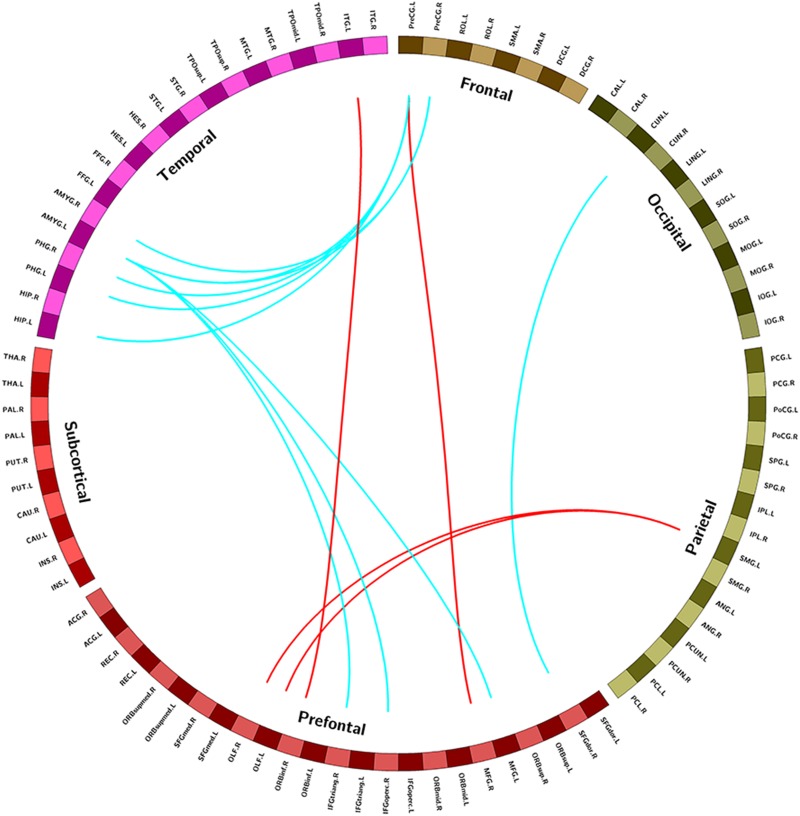
Regions exhibiting intergroup different FC between pregnant women with NSCLP and controls (p < 0.005, uncorrected). Brain regions were defined according to the AAL altas (Tzourio-Mazoyer et al., 2002), red edges were increased FC in NSCLP group compared with controls (p < 0.005 uncorrected), blue edges were decreased FC in NSCLP group compared with controls (p < 0.005 uncorrected).